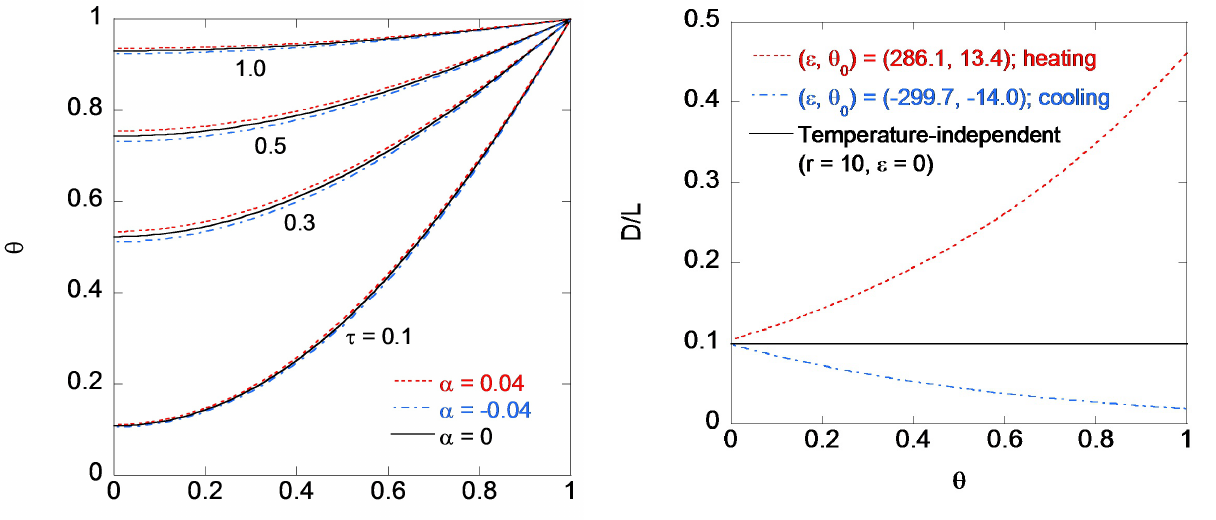
Fig. 5. Moisture diffusivity as a function of dimensionless tempera- ture for α = 0.